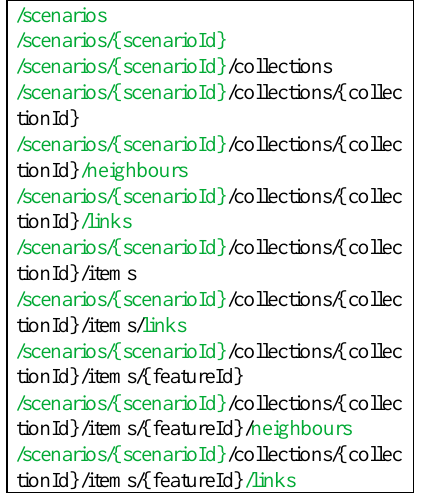
Table 1 . URI-Templates of API-Features (black) and envVisio Service (green)